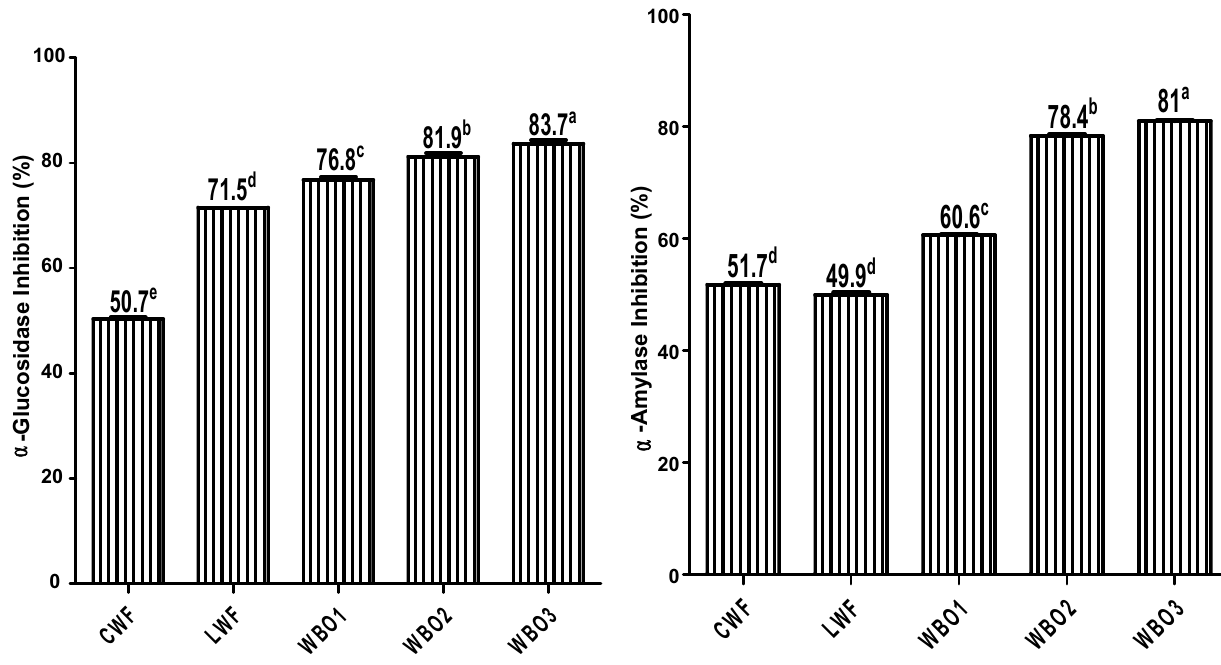
(WBO ); 25% wheat, and 75% bambara groundnut (WBO 2 mercial wheat flour (CWF) and Laboratory wheat flour